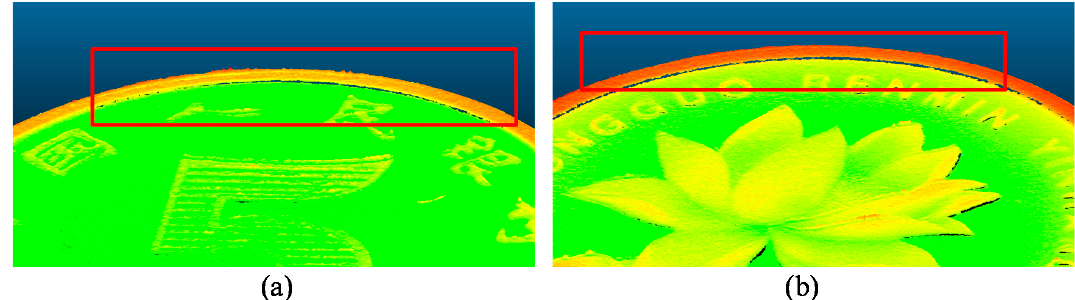
Figure 13. The manifestation of the unmeasured region due to the occlusion in a practical experiment. The unmeasured region is marked with red rectangular for the results of ( a ) Coin side 1 and ( b ) Coin side 2.